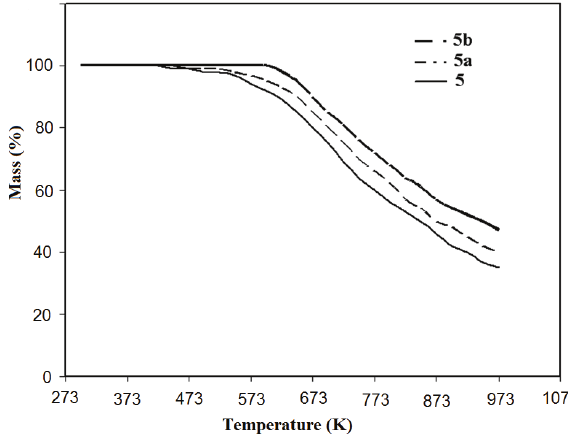
Figure 7. TGA thermograms of neat PAI 5 and PAI- nanocomposite films 5a & 5b